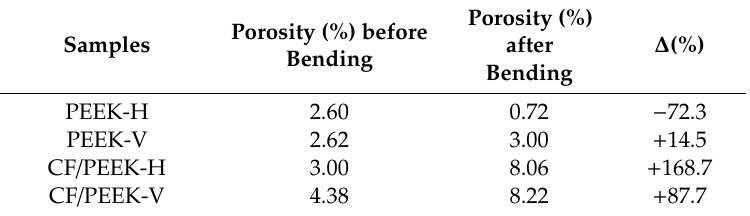
Table 3. The result of porosity analysis via X-ray computed tomography